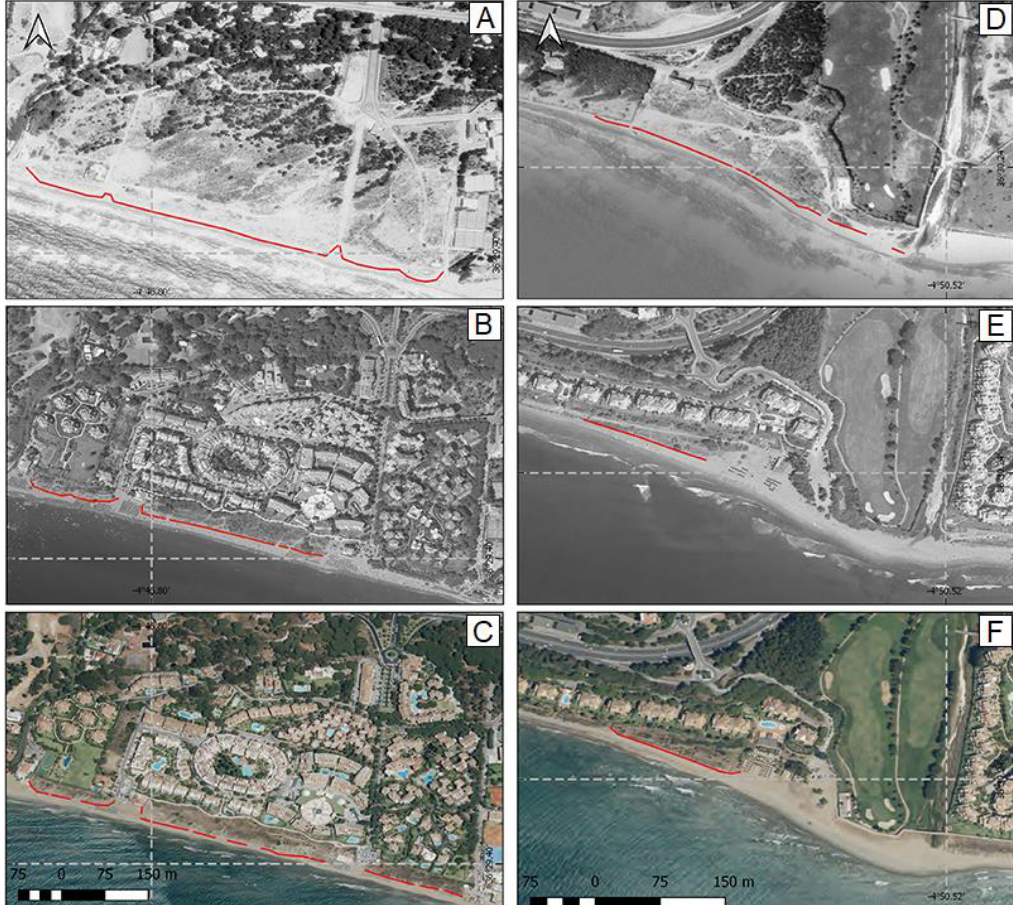
Figure 10. System no. 20 Playa de las Chapas, in Málaga province, recorded an increase of fragmentation due to the increment of anthropic pressure, changing from ( A ) Class 1 (F = 0.003) in 1977 to ( B ) Class 2 (F = 0.12) in 2001 and to ( C ) Class 3 (F = 0.22) in 2016. System no. 16 Playa de Río Real, in Málaga province, where the modification of the coastal zone and the emplacement of a touristic urbanization produced the destruction of the already fragmented dune system. Remnant dune systems presented a lower Fragmentation Index, changing from ( D ) Class 3 (F = 0.20) in 1977 to ( E ) Class 2 (F = 0.15) in 2001 and to ( F ) Class 1 (F = 0.0) in 2016. Red line represents dune toe position.